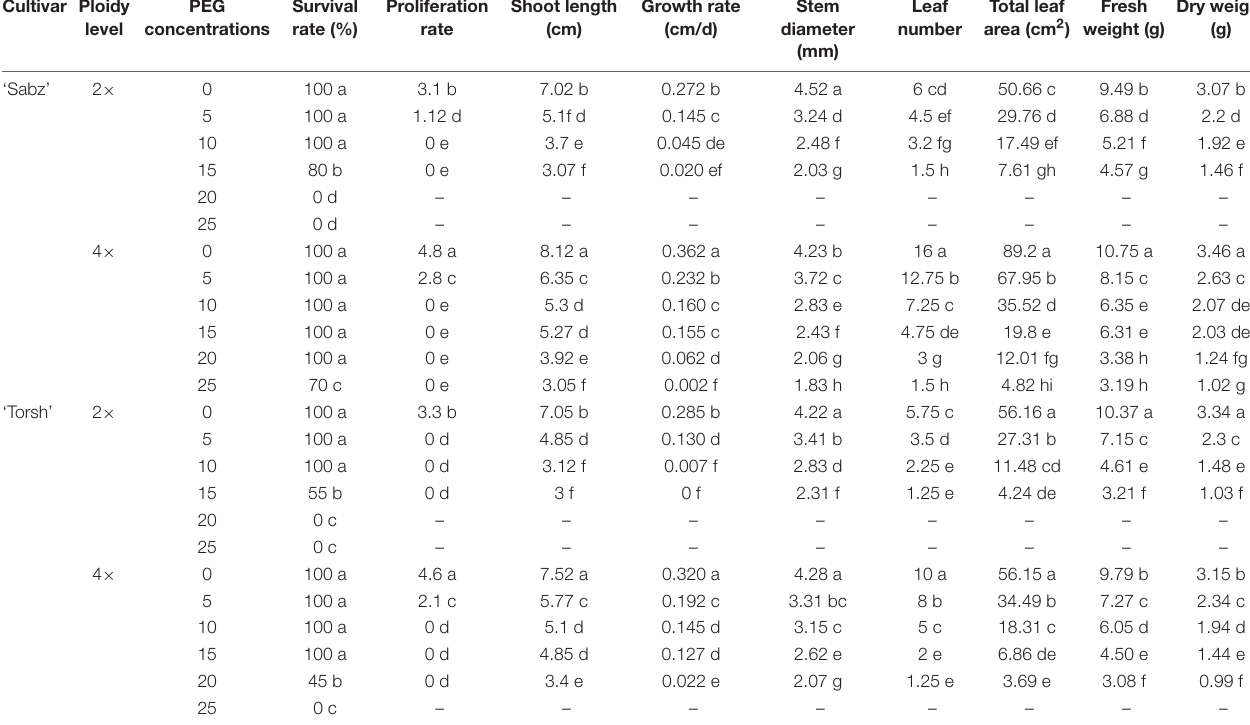
TABLE 1 | The effect of different PEG concentrations on survival rate, proliferation rate, and various morphological characteristics of tetraploid and diploid explants of ‘Sabz’ and ‘Torsh’ fig cultivars 14 days after subjecting to water stress treatments. Cultivar Ploidy